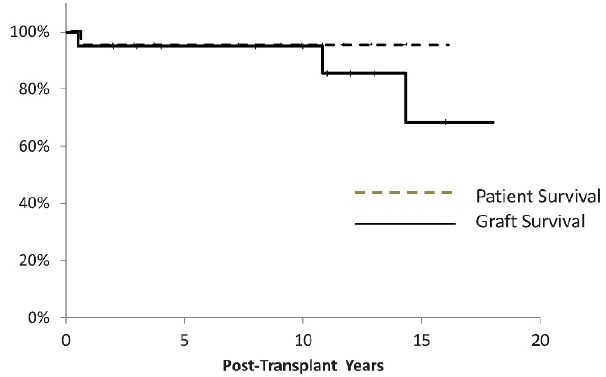
Figure 4 - Patient and Graft Survival from Pediatric ABOi at Toho